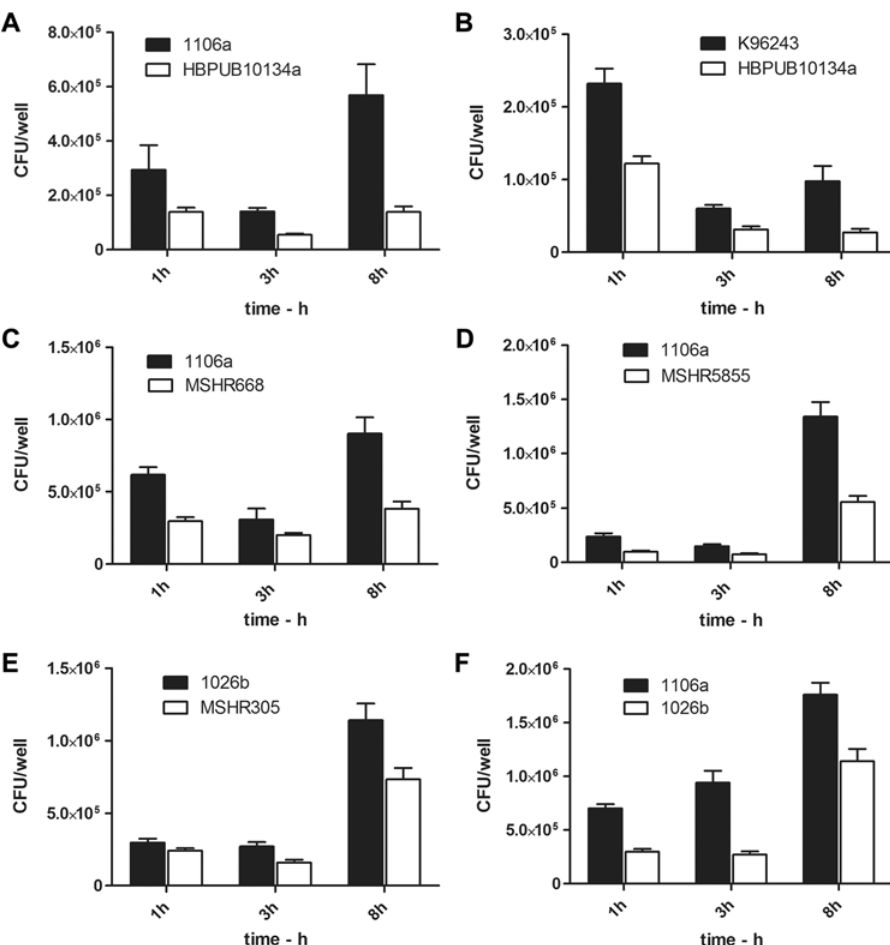
Fig 5. Comparisons of viable counts recovered from J774.A1 macrophages infected with different strains of B . pseudomallei . A. The MOIs for strains 1106a and HBPUB10134a were 17.2 and 13.7, respectively. Strain 1106a was phagocytosed to a greater extent than HBPUB10134a, as shown by the 1 h and 3 h viable counts and multiplied to a greater extent during the 5 h period between phagocytosis and the 8 h collections. The viable counts recovered from the macrophages of 1106a for all three time points were greater than those of HBPUB10134a: P = 0.0214 (1 h), P < 0.0001 (3 h), and P = 0.0018 (8 h). B. The MOIs for strains K96243 and HBPUB10134a were 27.5 and 26.5, respectively. The viable counts recovered from the macrophages of K96243 for all three time points were greater than those of HBPUB10134a: P < 0.0001 (1 h), 0.0006 (3 h), and 0.0052 (8 h). C. The MOIs for strains MSHR668 and 1106a were 8.9 and 5.8, respectively. The viable counts recovered from the macrophages of 1106a for all three time points were nearly or significantly greater than those of MSHR668: P < 0.0001 (1 h), P = 0.070 (3 h), and P = 0.0003 (8 h). D. The MOIs for strains 1106a and MSHR5855 were 12.4 and 7.7, respectively. The viable counts recovered from the macrophages of 1106a for all three time points were greater than those of MSHR5855: P = 0.0002 (1 h), 0.0019 (3 h), and < 0.0001 (8 h) E. The MOIs for strains 1026b and MSHR305 were 16.2 and 16.9, respectively. The viable counts recovered from the macrophages of 1026b were greater than those of MSHR5855 at the 3 h ( P = 0.0015) and 8 h time points ( P = 0.0097); the 1 h viable counts were not significantly different ( P = 0.077). F. The MOI for both the 1026b and 1106a strains was 16.2. The viable counts recovered from the macrophages of 1106a for all three time points were greater than those of 1026b: P = 0.0001 for 1 h and 3 h time points, and P = 0.0029 for the 8 h time